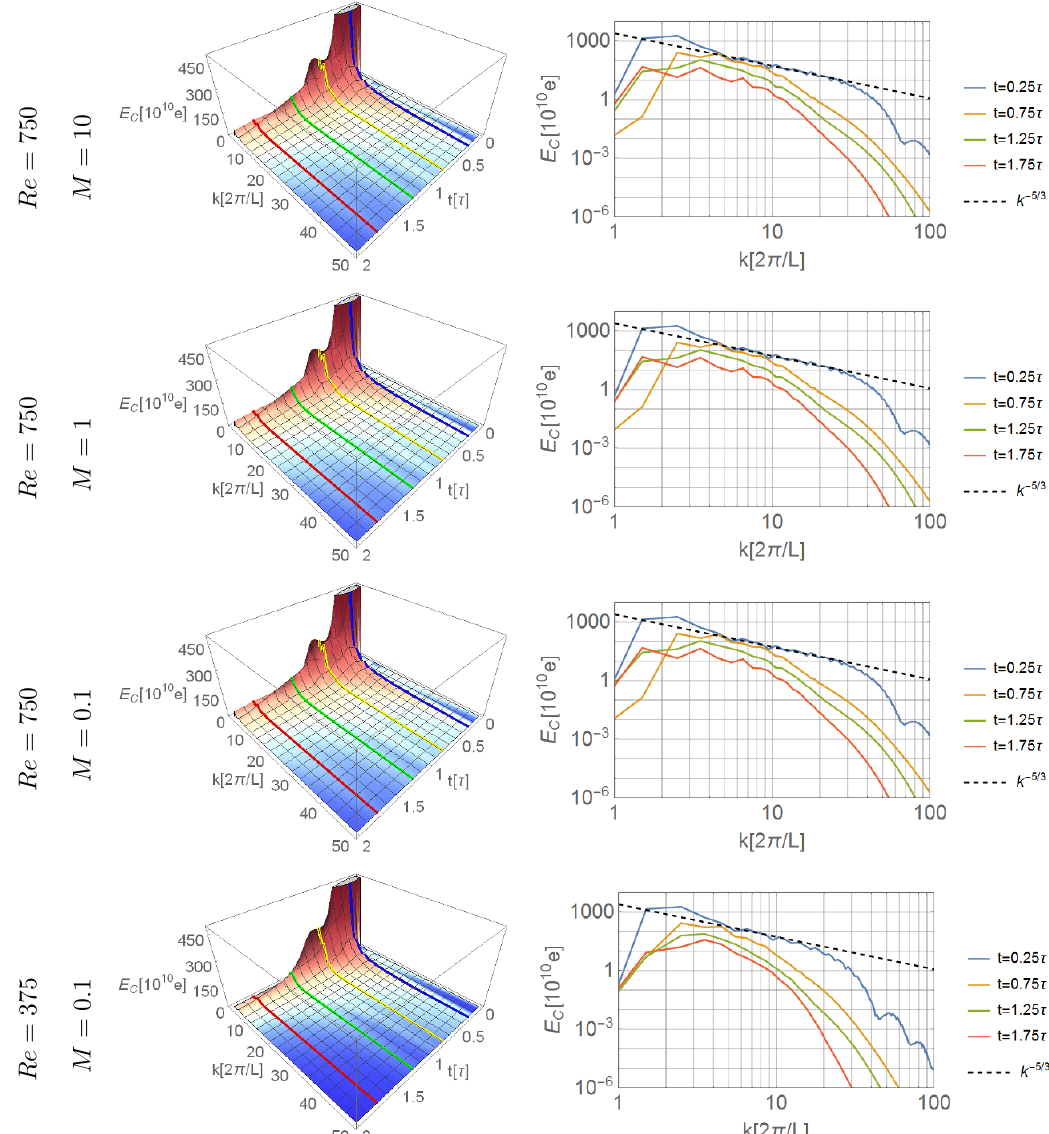
Figure 17 . On the left, the energy spectrum of three dimensional (cid:13)ows with initial mode n = 1 at intermediate times. On the right, log-log plots of selected times of same (cid:13)ows shown in color on the full temporal spectrum (on the left). The Mach number has no apparent e(cid:11)ect on the spectrum. All the plots display a clear signature of the expected power law E C ( t; k ) (cid:24) k (cid:0) 5 = 3 . The lowering of the Reynolds number shortens the k (cid:0) 5 = 3 scaling range from k 2 (4 ; 30) when Re = 750 to k 2 (4 ; 18) when Re = 375.